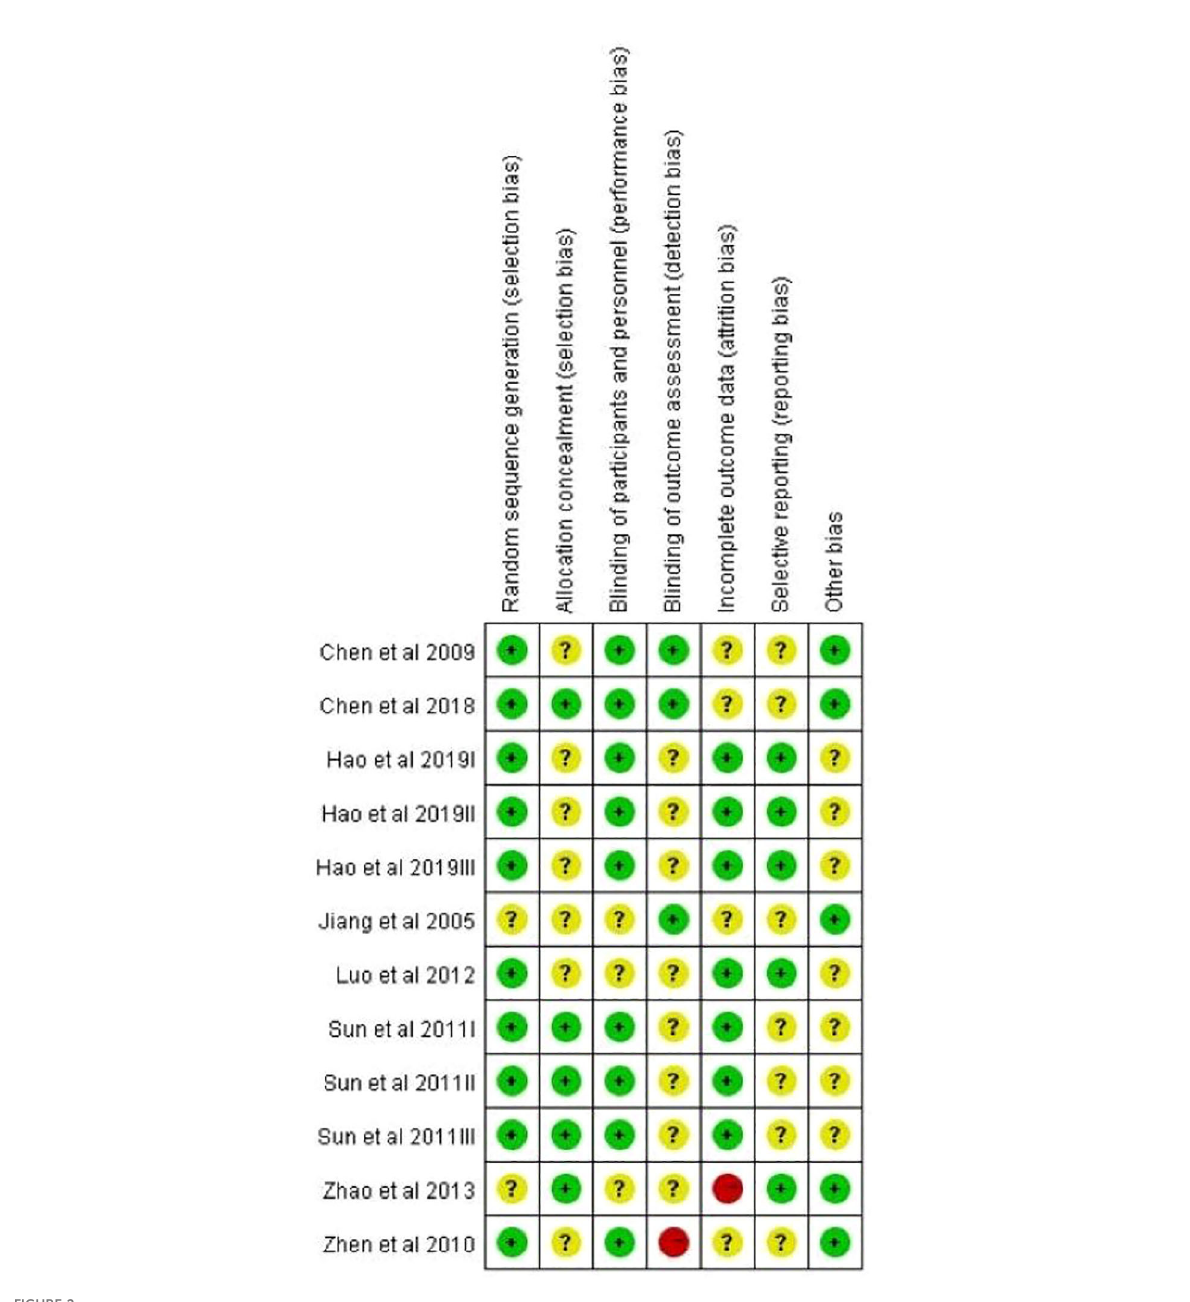
FIGURE 2 Summary of review authors ’ judgements about risk of bias across all domains and